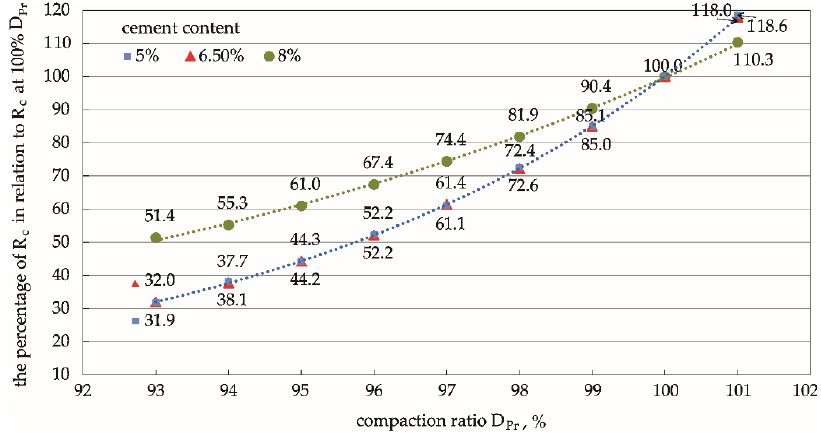
Figure 11. Corresponding relationships between the percentage of unconfined compressive strength, R c , under different compaction degrees in relation to R c at 100% D Pr . Cement content: — 5%, — 6.5%, — 8%.